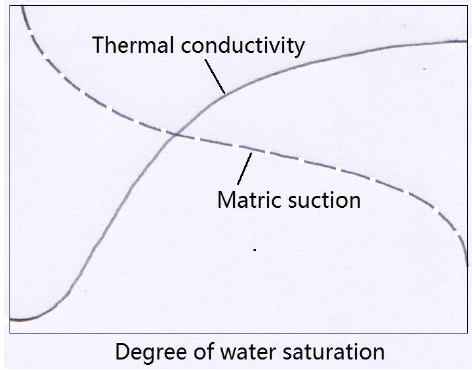
Figure 1. A comparison between the thermal conductivity and the soil-water retention.